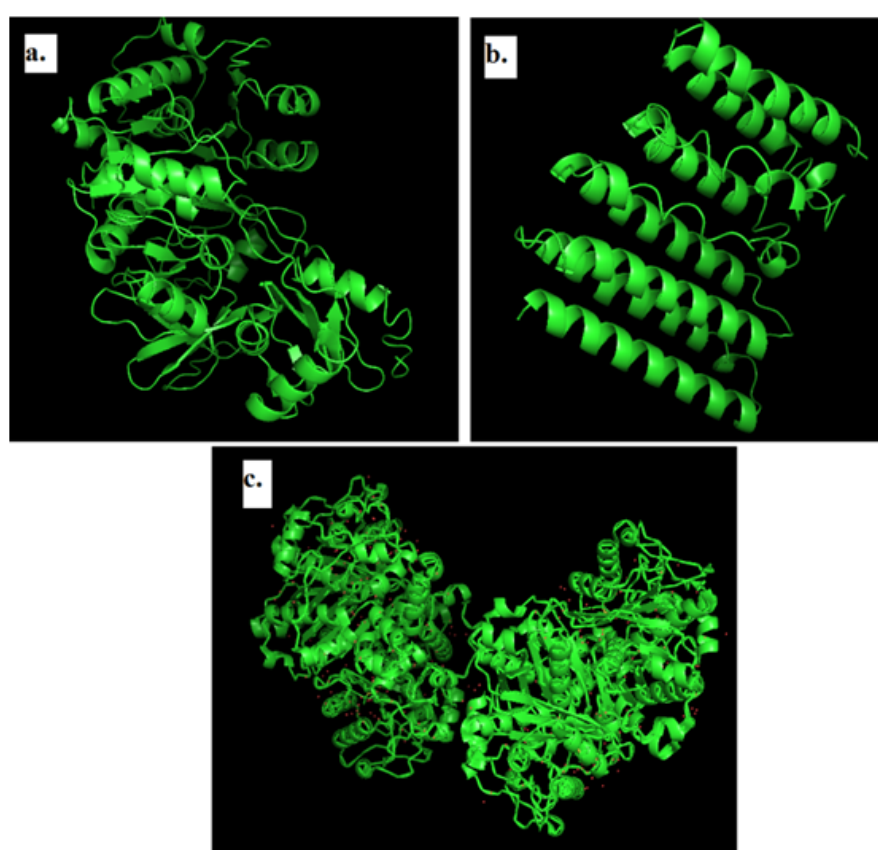
Figure 1. The 3D structure of modeled ( a ) Anthranilate ‐ CoA ligase, ( b ) 1, 3 ‐β –D ‐ glucan synthase, and ( c ) β‐ ketoacyl acyl carrier protein synthase I (PDB:1FJ4). I ‐ Tasser was used to generate five models, each with a C ‐ Score of − 2.50, − 3.01, − 4.19, − 5,